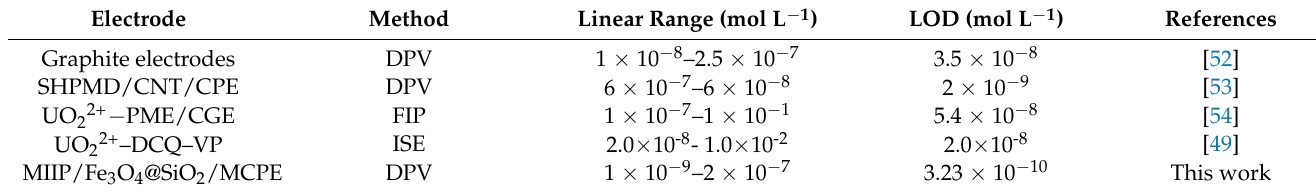
Table 2. Comparison of this method with other electrochemical methods for the determination of UO 22+ .